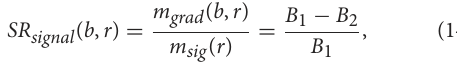
r − 2 with distance to the different ∝